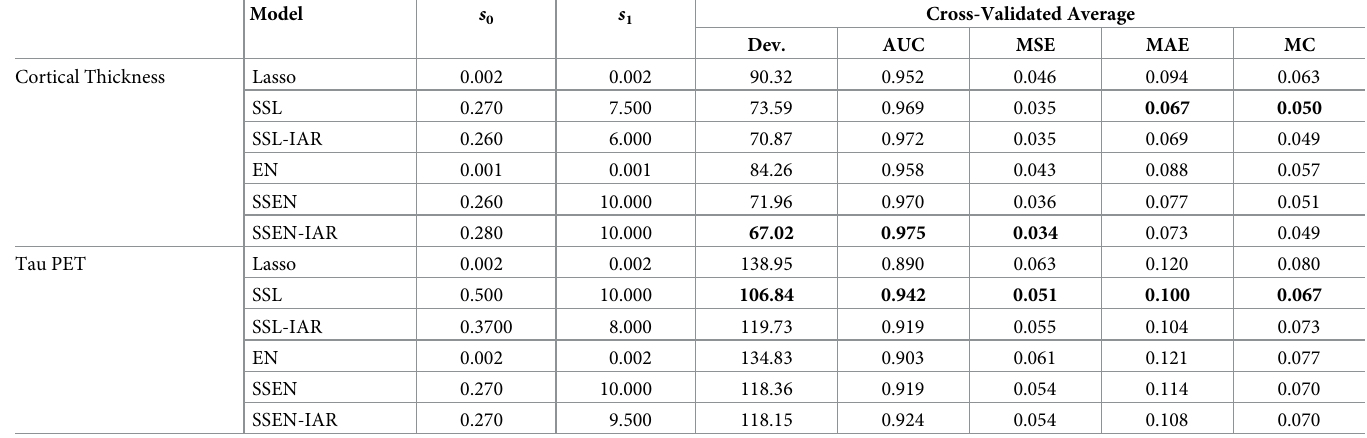
Table 1; model fitness for cortical thickness was explored in other work, but this work did not explore classification performance or utilize tau PET images, and we reproduce model fitness estimates for cortical thickness here for completeness and due to their relevance to the current work [24]. For the cortical thickness data SSEN-IAR has the lowest deviance and MSE, and Table 1. ADNI: Prediction error